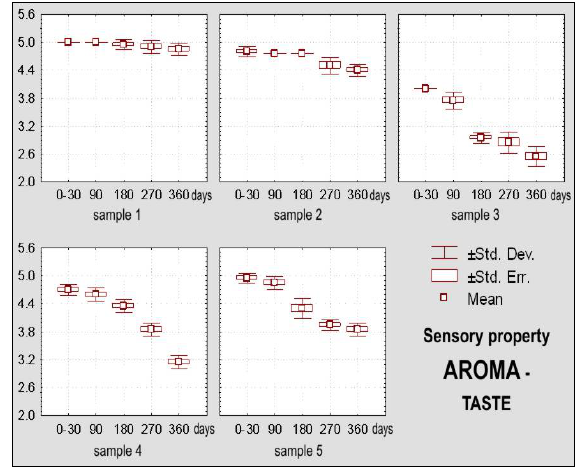
Figure 15 . Box-plots for sensory attribute aroma – taste of dietary